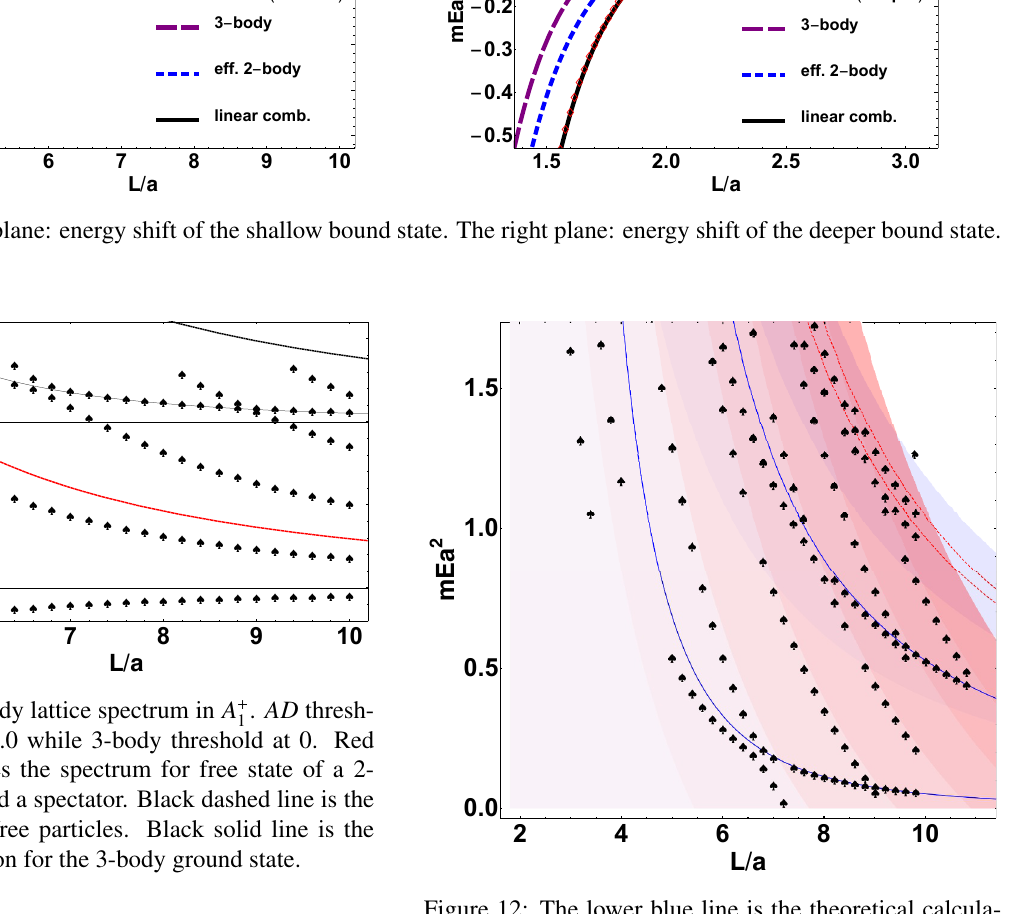
up to O (1 / L 6 ) 1